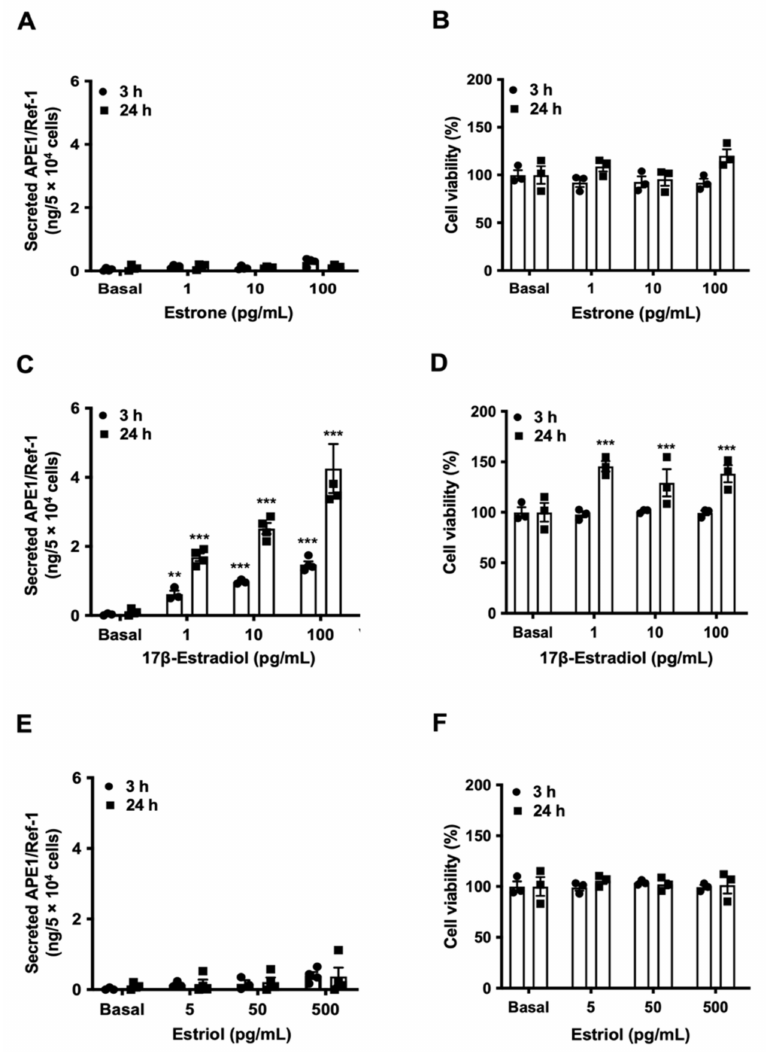
Figure 2. Differential regulation of apurinic/apyrimidinic endonuclease-1/redox factor-1 (APE1/Ref-1) secretion by estrogen. The effect of estrone ( A ), 17 β -estradiol ( C ), and estriol ( E ) on APE1/Ref-1 levels in the culture media of vascular endothelial cells. The effect of estrone ( B ), 17 β -estradiol ( D ), and estriol ( F ) on cell viability of vascular endothelial cells. Columns, mean (n s= 3–4); dot plot, SE. *** p < 0.001, ** p < 0.01, indicates a significant difference compared to that of control cells (Basal) according to an unpaired t